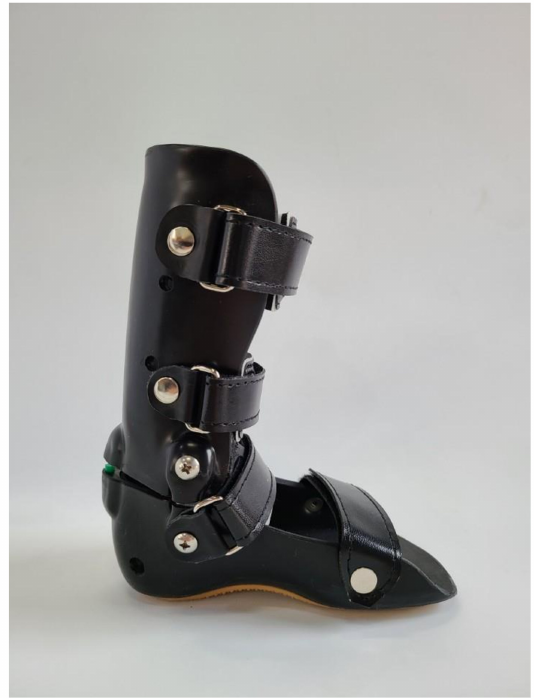
Figure 2. The hinged ankle–foot